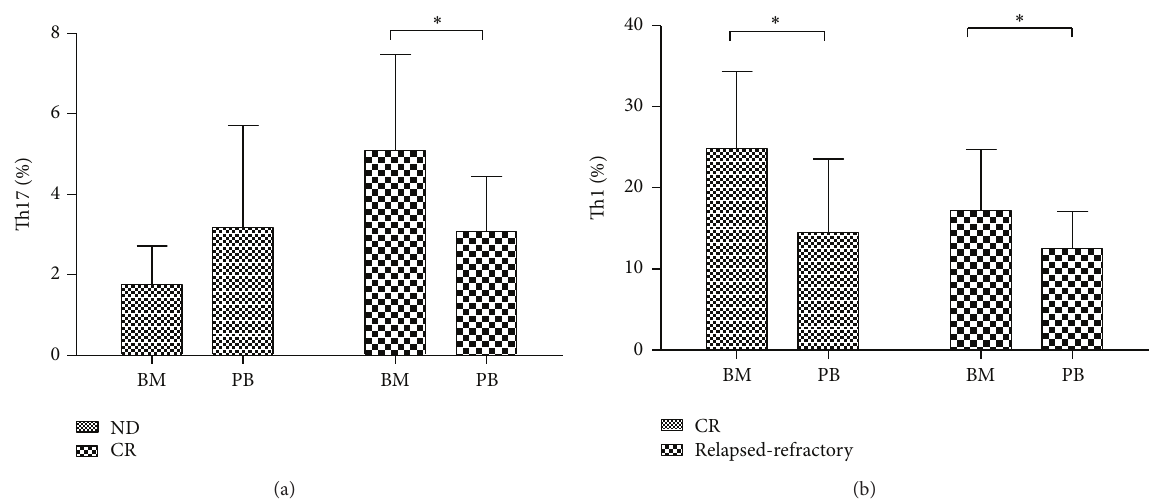
Figure 3: The comparison of Th17 or Th1 cells in BM and PB in different stages of AML patients. (a) Th17 cells percentage was markedly higher in BM than in PB in CR AML patients. (B) Th1 cells percentage was significantly increased in BM compared with in PB of CR or relapsed-refractory patients.